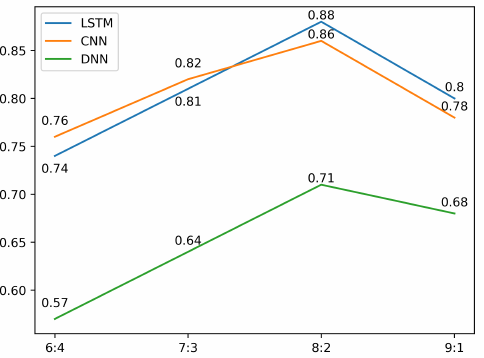
Figure 8. Comparison of different ratios of the training set and test set.